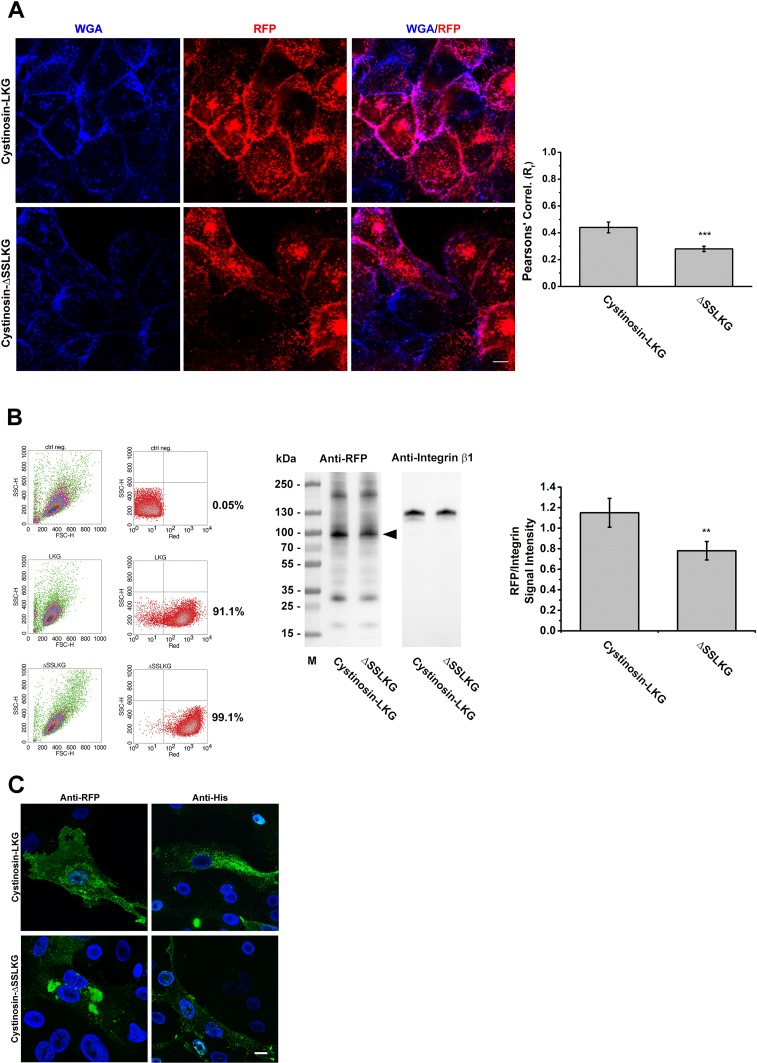
Differential expression of the cystinosin-LKG and ΔSSLKG mutant on the plasma membrane.HK-2 cells stably transfected with RFP-tagged cystinosin-LKG or ΔSSLKG were stained with WGA Blue to mark the plasma membrane. Colocalization analysis shows that deletion of -SSLKG motif reduces about 35% (p < 0.001) expression of the carrier on the plasma membrane (A). Scale bar = 10 μm, means ± SEM of four experiments are shown. Stably transfected cells with cystinosin-LKG or ΔSSLKG mutant were analyzed by cytofluorimetry to define the transfection efficiency, and a cell surface protein biotinylation for SDS-PAGE analysis was performed. Quantitative analysis by evaluation of RFP signal normalized with Integrin β1 shows about 30% reduction (p < 0.01) in ΔSSLKG mutant (B). Means ± SEM of three experiments are shown. HK-2 cells transiently transfected with RFP- or V5His-tagged cystinosin-LKG and ΔSSLKG were immunolabeled using anti-RFP/ Alexa Fluor® 488 goat anti-rabbit IgG antibody or anti-His Tag/Alexa Fluor® 488 goat anti-mouse IgG antibody, respectively (C). Scale bar = 10 μm.